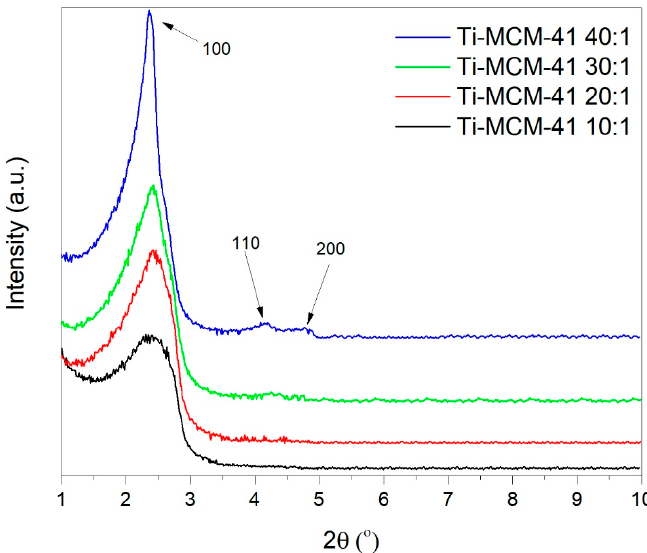
Figure 2. Low-angle X-ray diffraction patterns for Ti-MCM-41 samples with different molar ratios of Si:Ti in the crystallization gel (respectively, 40:1, 30:1, 20:1, and 10:1). Si:Ti in the crystallization gel (respectively, 40:1, 30:1, 20:1, and